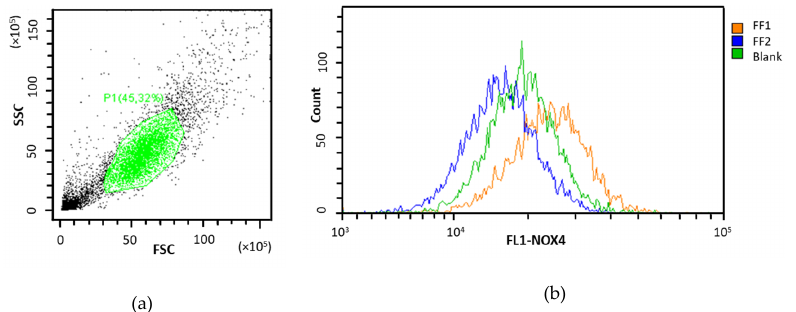
Figure 9. ( a ) Detection of human fetal lung fibroblasts according to FL1-NOX4 and ( b ) distribution of cells treated with FF1 and FF2 according to the FL1-NOX4. In blank experiments, cells were incubated without the FFs.